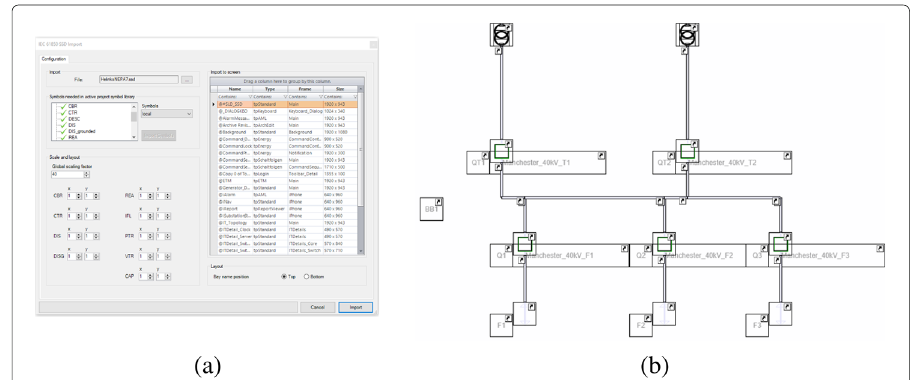
Fig. 5 HMI generation: ( a ) Wizard ( b ) Generated HMI diagram